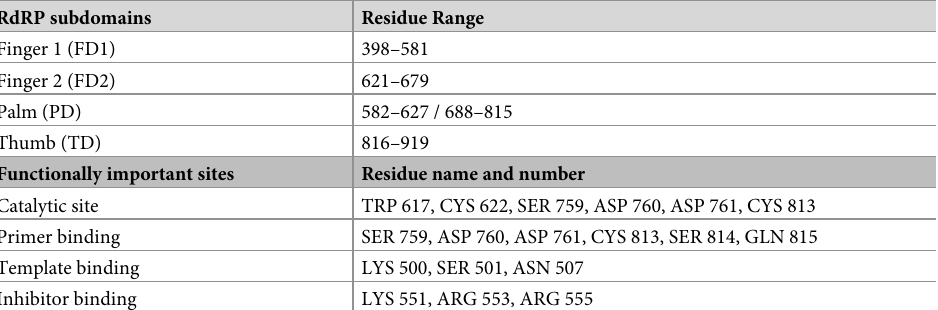
Table 1. Residue range and number for the subdomains and functionally important sites of the